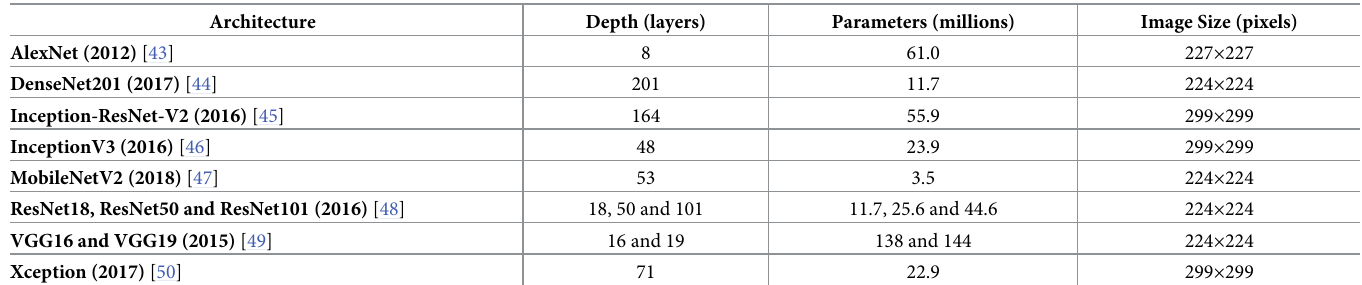
Table 3. The list of the DCNNs used and the summary of their architecture. Architecture